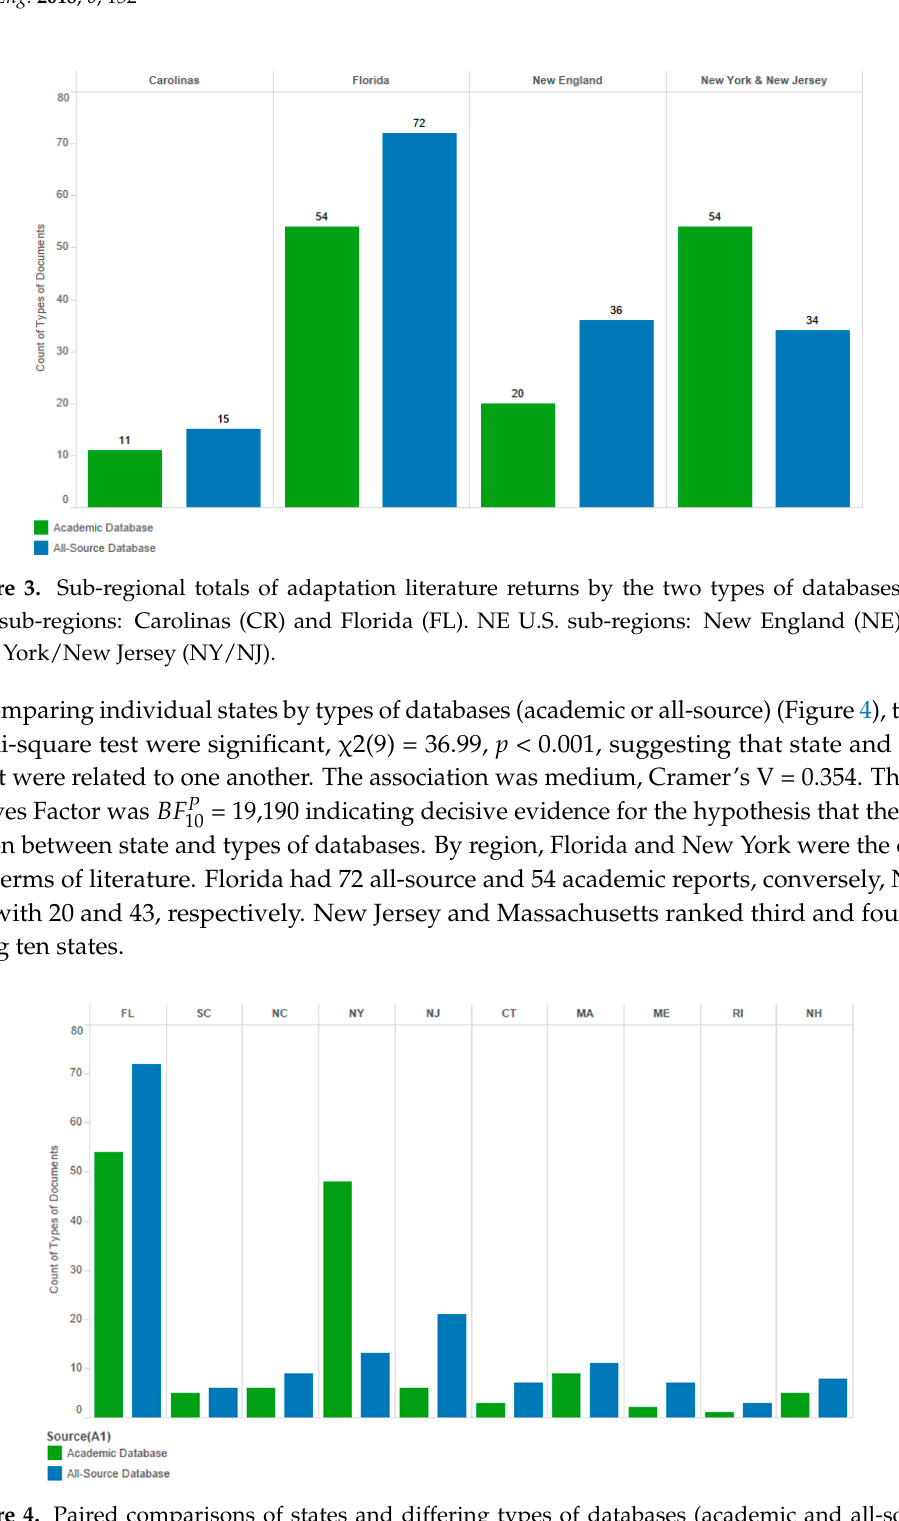
Figure 4. Paired comparisons of states and differing types of databases (academic and all-source databases) across ten U.S. east coast states.